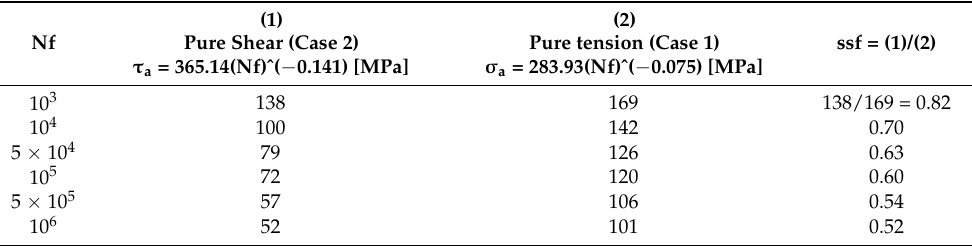
Table 5. ssf results for Case 1—AZ31B-F.